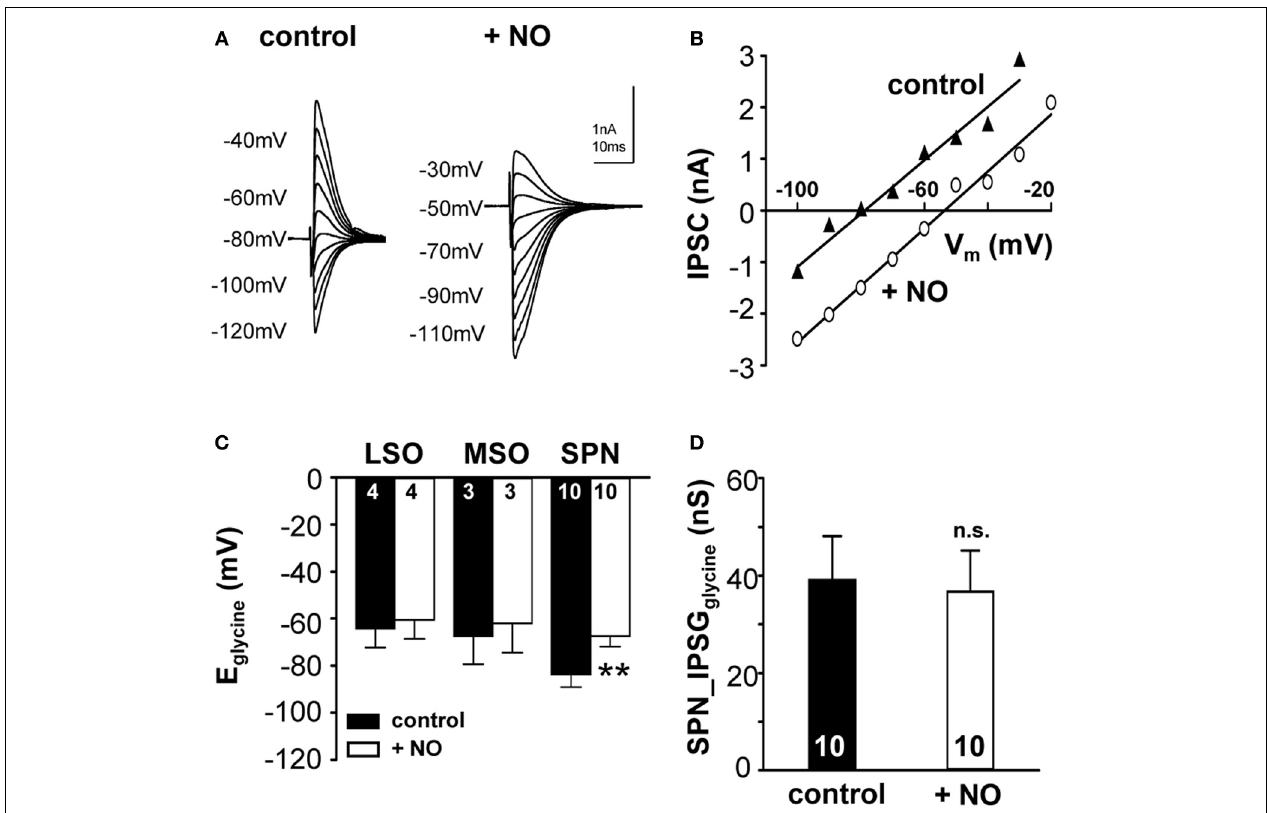
FIGURE 3 | Nitric oxide suppresses KCC2 activity. (A) Glycinergic IPSCs were evoked in a mouse SPN neuron by electrical stimulation of the MNTB. The command potentials ranged from − 120 to − 30mV in steps of 10mV. The IPSC reversal potential changed from − 80mV in control conditions to − 50mV after the modulation of KCC2 activity by NO signaling. (B) Current–voltage relationship for the SPN-IPSCs shown in (A) . The parallel